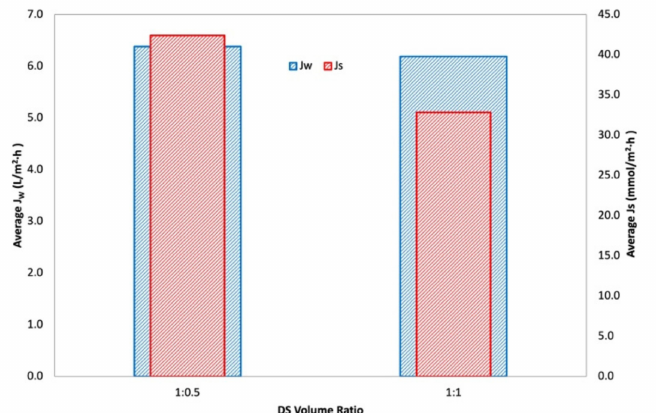
Figure 6. Average water flux, J W , and average reverse salt flux, Js, for 0.5 M NaCl, 600 mL/min, at a varying draw solution volume ratio (1:0.5 and 1:1).